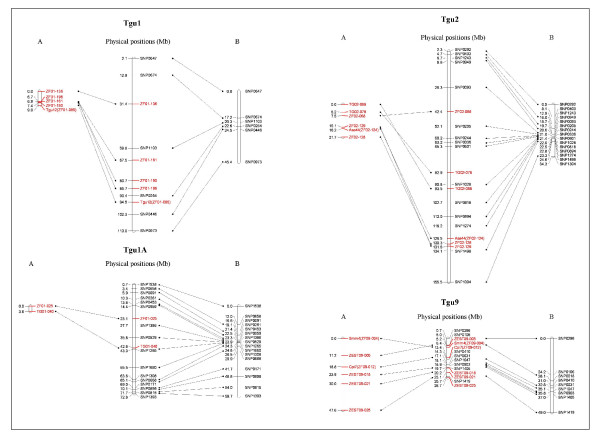
Separate SNP and microsatellite framework maps. Linkage maps built via the conventional method show that (A) marker order of microsatellites maps does not always correspond to the physical order on the zebra finch genome assembly (centre). However, for all four chromosomes the order of maps built with only the SNP markers (B) does agree with the zebra finch assembly order. Framework maps with marker order supported by LOD ≥ 3 are presented. Microsatellites are highlighted in red and linkage map positions are given in cM (A and B). The predicted genome assembly positions for the markers (centre) are given in Mb.